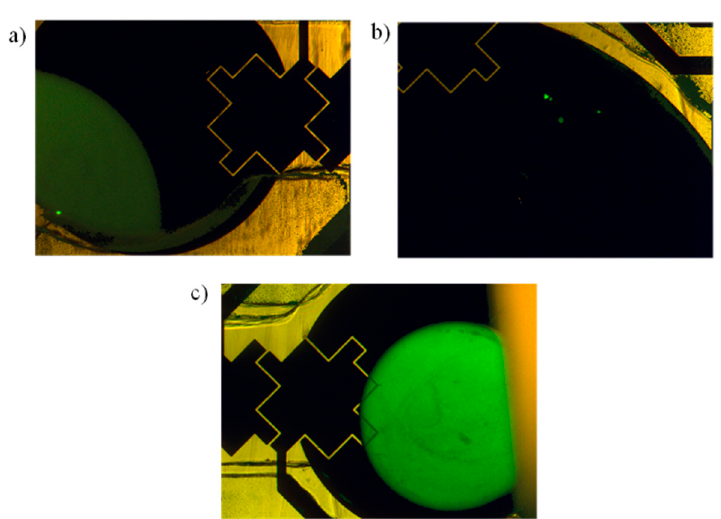
Figure 18. Plate reader plot.